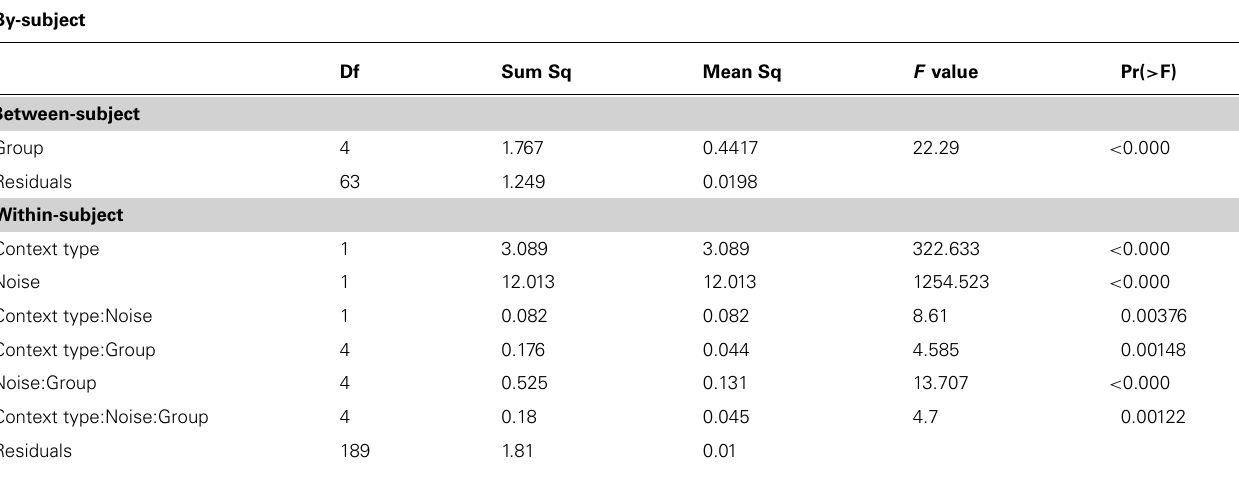
Table 3 | Repeated measuresANOVA results for Experiment 1: speech in noise, by-subject analyses.